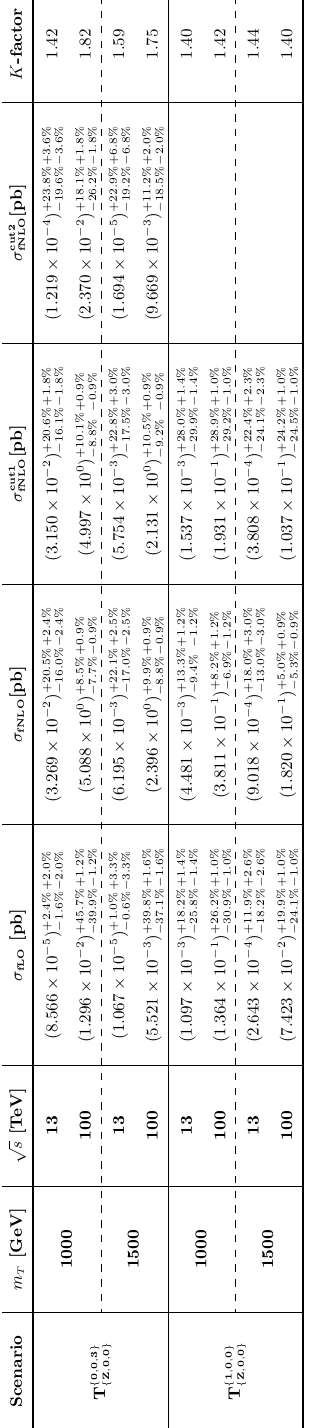
, we apply a cut on the invariant mass fNLO > 2 m t . The K -factor, given in the last t (cid:22) t =(cid:27) for T f 1 ; 0 ; 0 g and (cid:27) cut2 =(cid:27) for T f 0 ; 0 ; 3 g fLO fLO f Z ; 0 ; 0 g f Z ; 0 ; 0 g fNLO fNLO